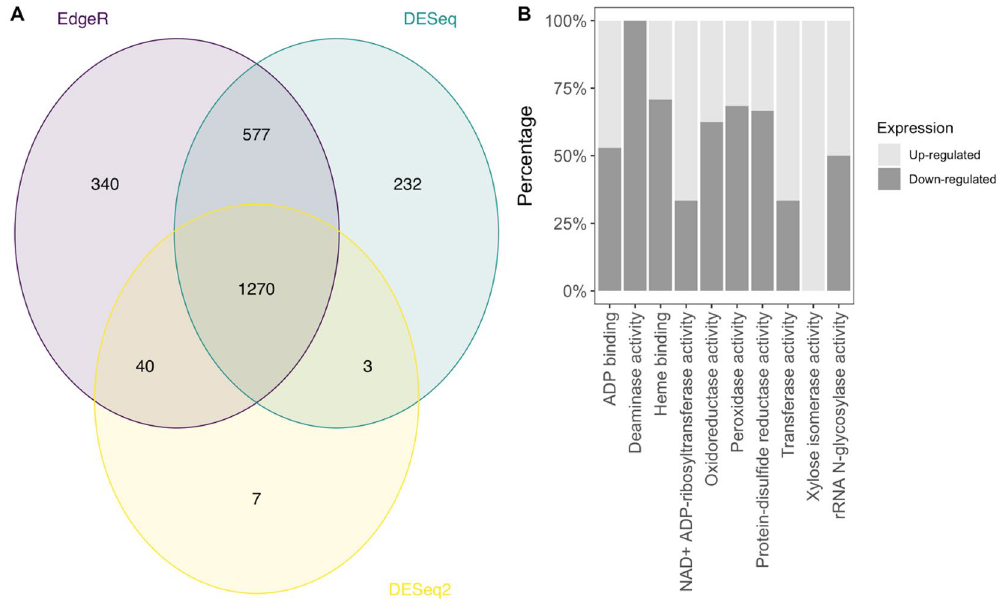
Figure 4. Comparison of gene expression in crown root tips between ICML-IS 11139 and ICML-IS 11084. ( A ) Venn diagram representing the number of genes that are significantly differentially expressed according to three different statistical tests (EdgeR, DESeq and DESeq2; p value < 0.05) and the overlaps. ( B ) Main GO terms overrepresented in the